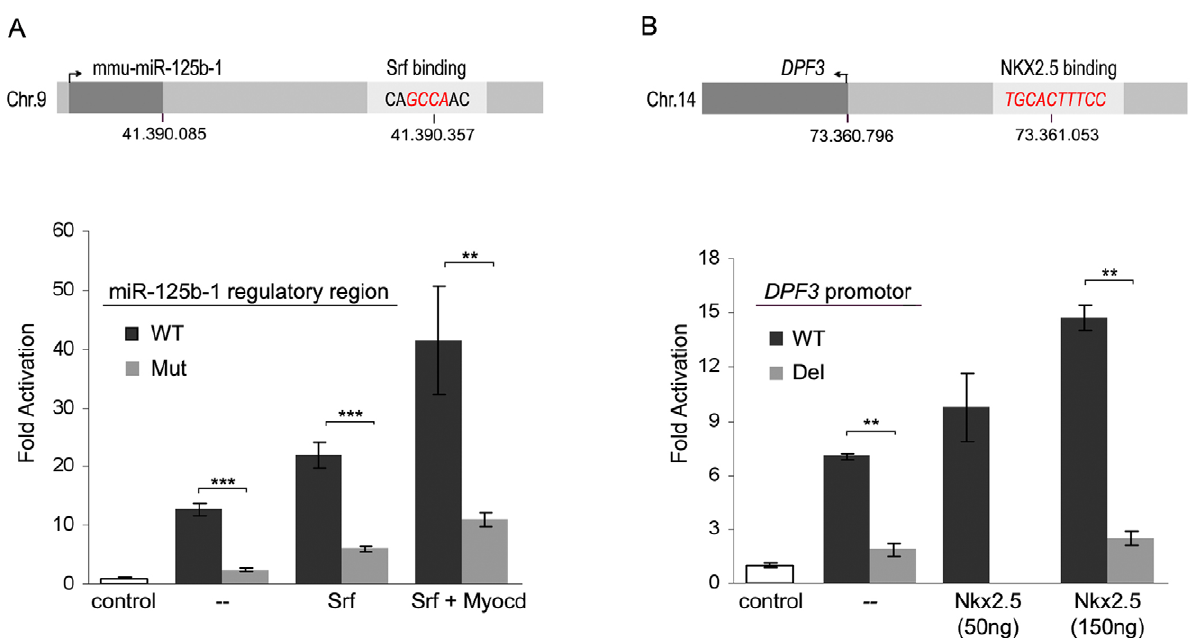
Figure 6. Promoter analysis of miR-125b-1 and DPF3 . (A) Srf ChIP-seq analysis revealed an Srf binding region downstream of mmu-miR-125b-1. Shown are the positions of mmu-miR-125b-1 and the Srf binding motif with its core sequence in red. The Srf ChIP-seq peak region was cloned as mmu-miR-125b-1 promoter into the pGL3basic vector for luciferase reporter gene assay. Srf alone and in combination with its cofactor Myocardin (Myocd) significantly increases the activation of the luciferase beyond activation driven by endogenous Srf. Mutation of the core sequence (GCCA R TAGT) of the Srf binding motif (Mut) abolished activation by Srf and Myocd compared to the wildtype (WT). (B) ChIP-chip showed binding of Nkx2.5 to an evolutionary human-mouse conserved region of the DPF3 core promoter. Depicted is the Nkx2.5 binding element, which were deleted for luciferase reporter gene assays (red). The DPF3 core promoter fused to luciferase alone and in combination with increasing amounts of Nkx2.5 expression vector showed dose-dependent activation by Nkx2.5 beyond the endogenous Nkx2.5 activation. Deletion of the Nkx2.5 binding element (red) abolished activation by Nkx2.5 compared to the wildtype (WT). The empty pcDNA3.1 expression vector and the empty pGL3basic luciferase reporter vector served as controls for transcription factors and reporter constructs, respectively. The resulting p-values are indicated: p , 0.001 (***), p , 0.01 (**).